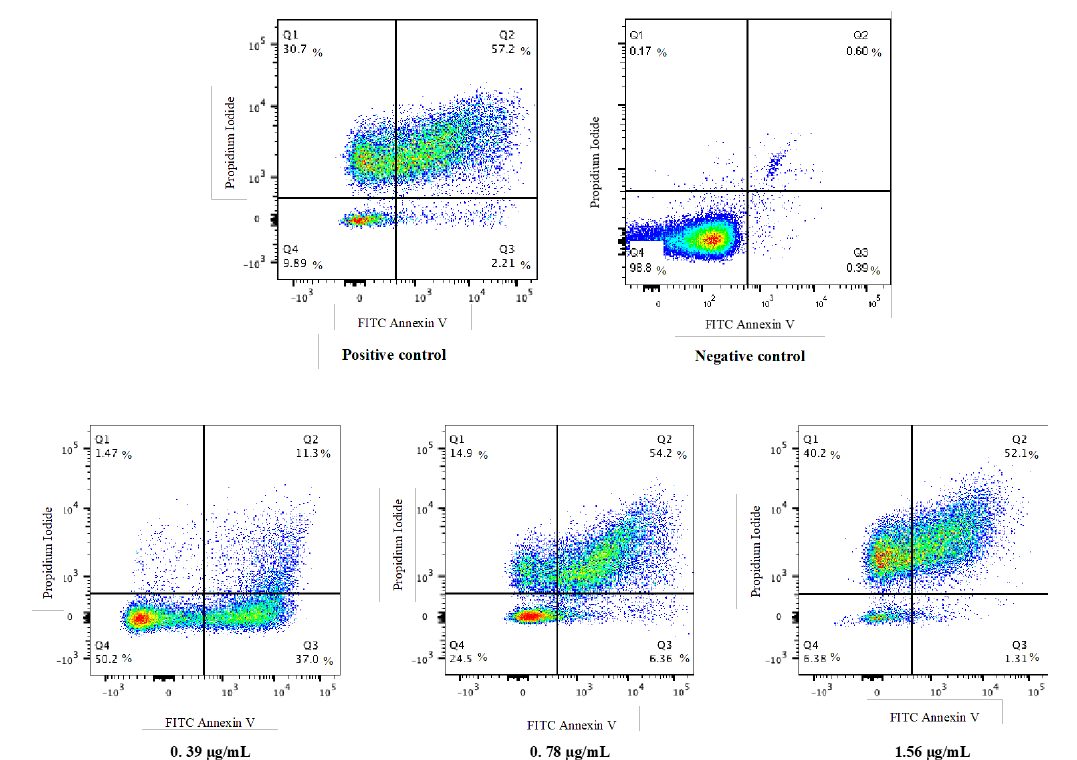
Figure 8. Flow cytometric analysis of phosphatidylserine exposure using AnnexinV/propidium iodide double staining. C. auris cells were treated with different concentrations of Ag-Cu-Co Trimetallic nanoparticles. Untreated cells were considered a negative control, whereas H 2 O 2 (10 mM) was added for positive control. Cells exposed to Ag-Cu-Co Trimetallic nanoparticles at different concentrations values (0.39 µg/mL, ½ MIC; 0.78 µg/mL, MIC; 1.56 µg/mL, MFC) of Ag-Cu-Co Trimetallic nanoparticles. Table 3. Percentage of cells present in different quadrants (Q1–Q4) of the quadrant dot plot.